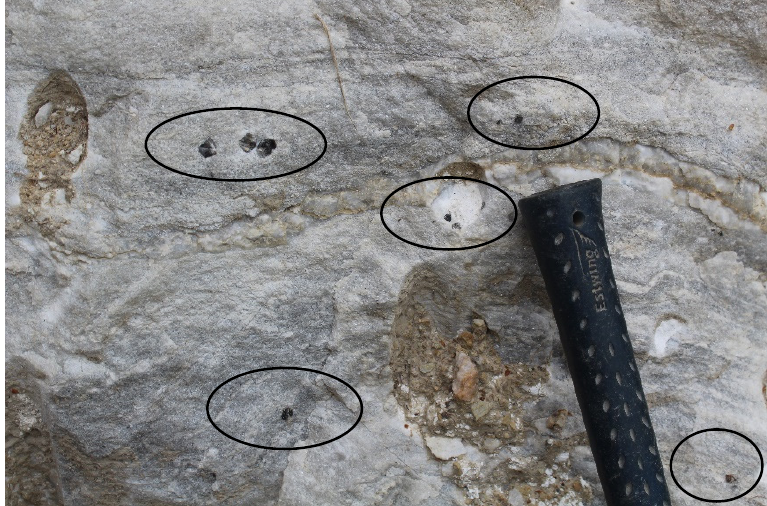
Figure 5. Anhydrite levels with black quartz crystals, from Mt. Rosso.